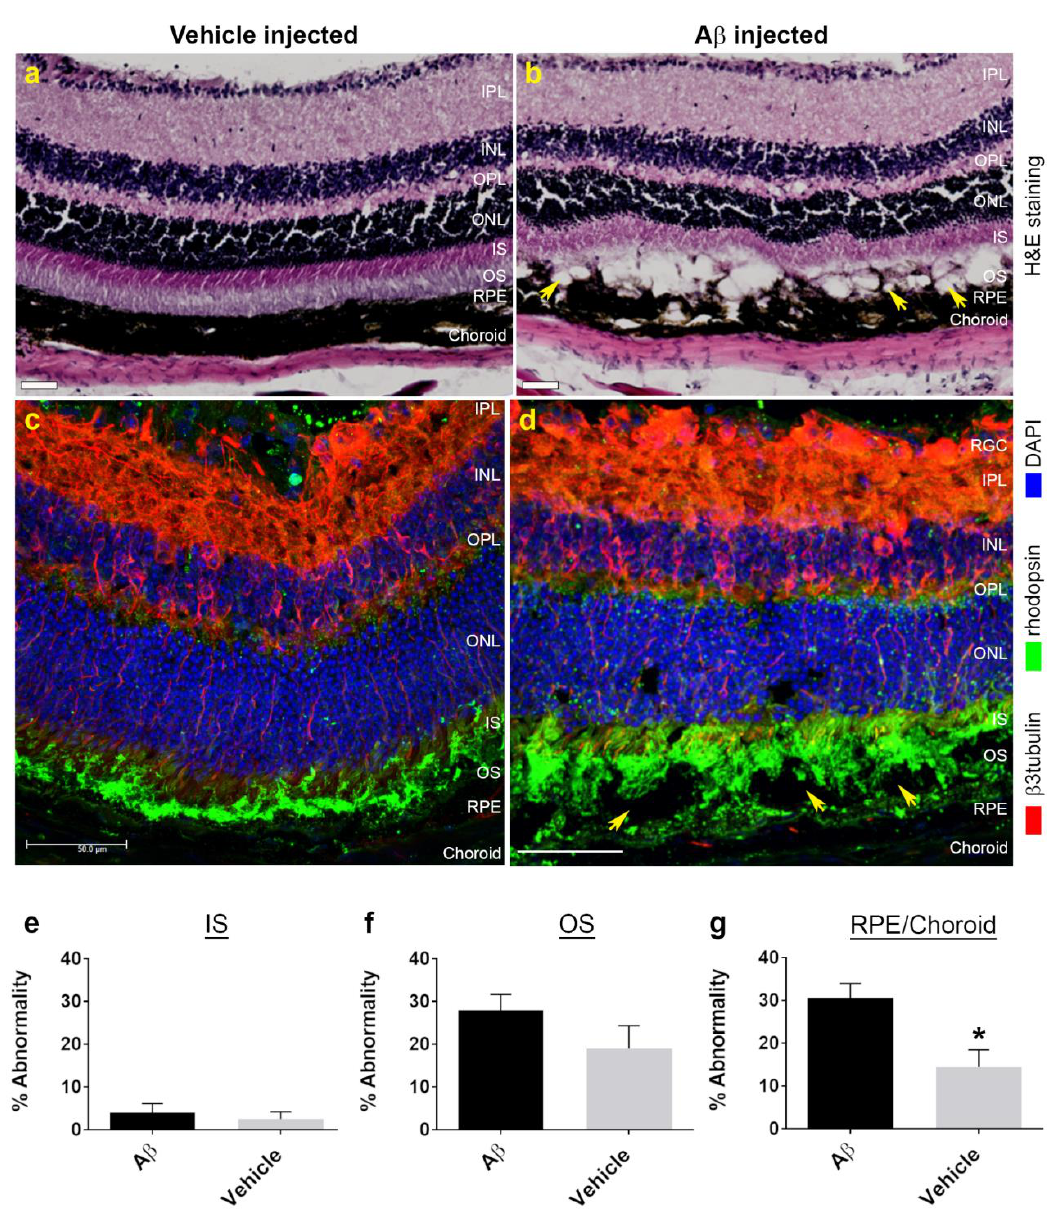
Figure 3. AMD-like histopathology in the outer retina of mouse eyes exposed to human oligomeric Aβ 1-42 at one week post-injection. ( a ) Hematoxylin and eosin (H&E) staining of tissues from vehicle-injected mouse eyes showed a healthy retina compared to ( b ) eyes exposed to Aβ, where we observed evidence of significant outer retinal disruption. This included diminished inner segments, absence of photoreceptor outer segments as well as a disorganized/atrophic RPE and choroid in a localized area. We also observed the appearance of cystic-like spaces (arrows), which perhaps correspond to areas of subretinal fluid accumulation seen in OCT scans. Scale bars correspond to 50 μm. ( c ) Retinal cross-sections were also probed with anti-rhodopsin to label outer segments (green) and β3-tubulin which labelled retinal neurons (red). ( d ) These studies confirmed the extent of photoreceptor-RPE disruption observed in H&E sections of Aβ-exposed eyes. In contrast, vehicle-injected eyes showed no evidence of any pathology ( c ). Scale bars correspond to 50 μm. Next, we performed line-scan analysis of H&E sections to quantify the extent of Aβ-mediated retinal pathology which is shown as histograms for percentage abnormality on an arbitrary scale. Pathology in Aβ- vs. vehicle-injected eyes was assessed using an unpaired Student’s t -test which revealed no differences in ( e ) inner segments, p = 0.71 or ( f ) outer segments, p = 0.26. ( g ) However, compared to vehicle-treated eyes, we observed a significant level of disruption in the RPE-choroid, p = 0.03 in Aβ-exposed eyes. Measurements in n = 6 mice for vehicle-injected and n = 7 mice for Aβ injected. Error bars represent S.E.M. * denotes a significance of p ˂ 0.05.